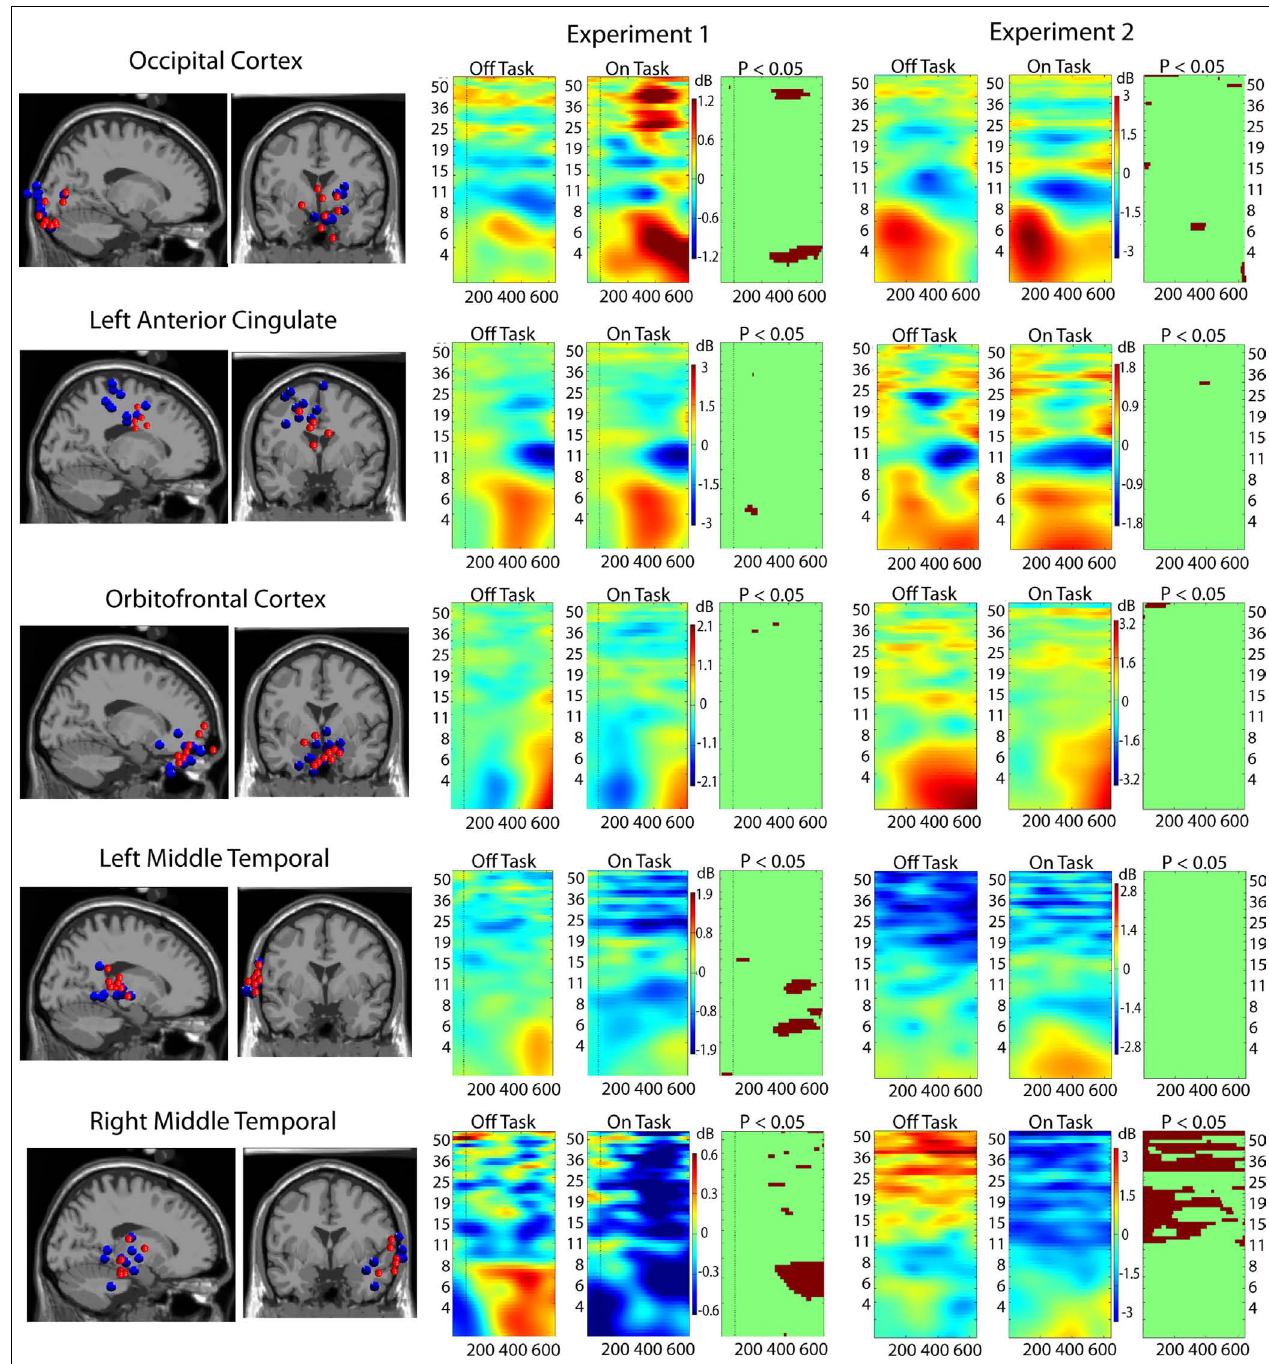
dots and Experiment 2 in blue dots. Rightmost three columns display ERSP results (Off-task and On-task) and the On-task Off-task difference masked at p = 0.05 by permutation